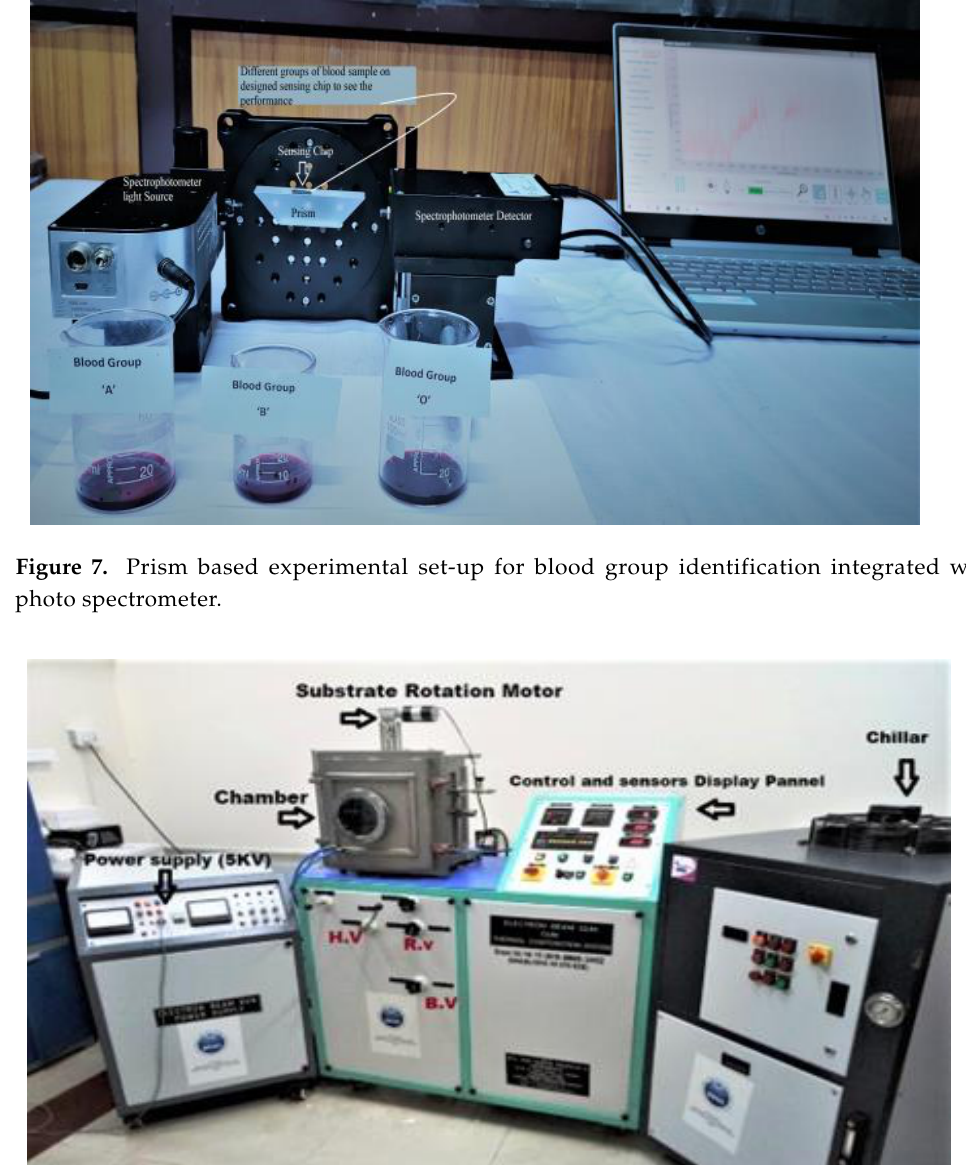
Figure 8. Complete set up of Deposition Machine.